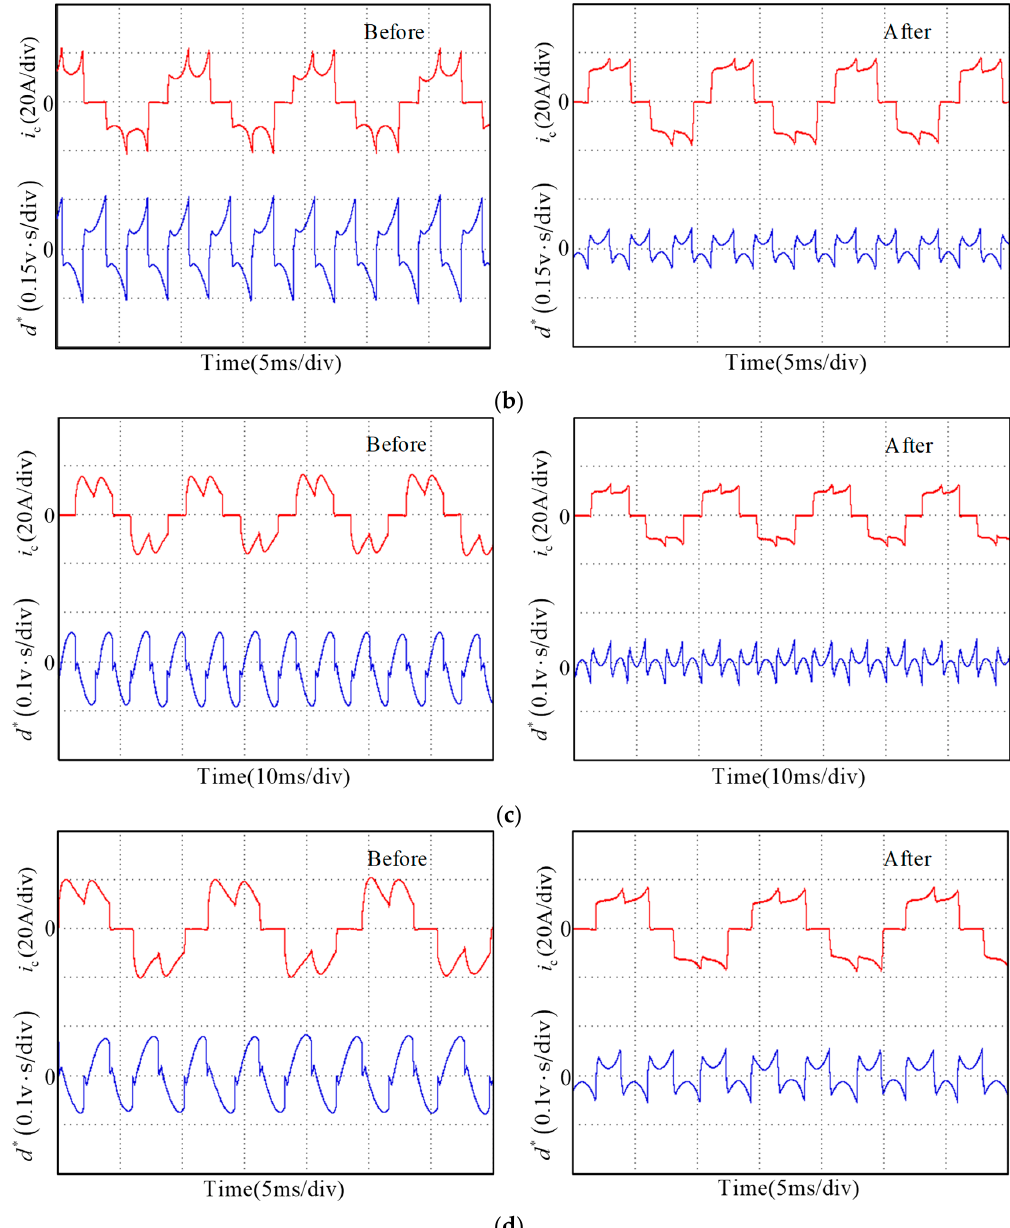
Figure 13. Current waveform of phase C before and after compensation. ( a ) Commutation instants are delayed by 10° at a speed of 1000 rpm and load torque of 12 Nm; ( b ) Commutation instants are delayed by 12° at a speed of 1500 rpm and load torque of 16 Nm; ( c ) Commutation instants are advanced by 12° at a speed of 850 rpm and load torque of 10 Nm; ( d ) Commutation instants are advanced by 14° at a speed of 1200 rpm and load torque of 14 Nm.